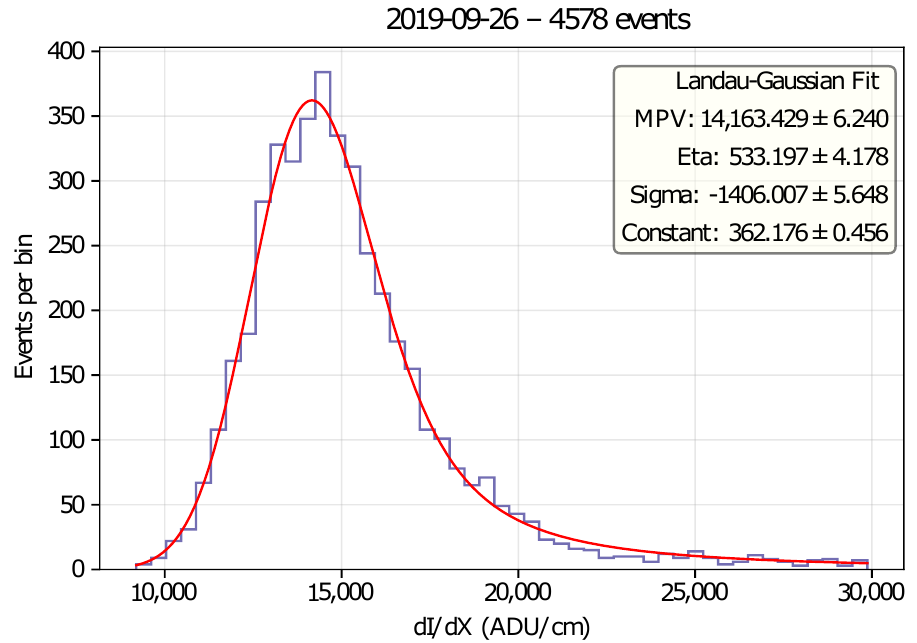
Figure 12. The distribution of dI —the lifetime-corrected ToT summation—for a population of dX through-going muon tracks. A Landau-Gaussian convolution function (red) has been fitted to the entire